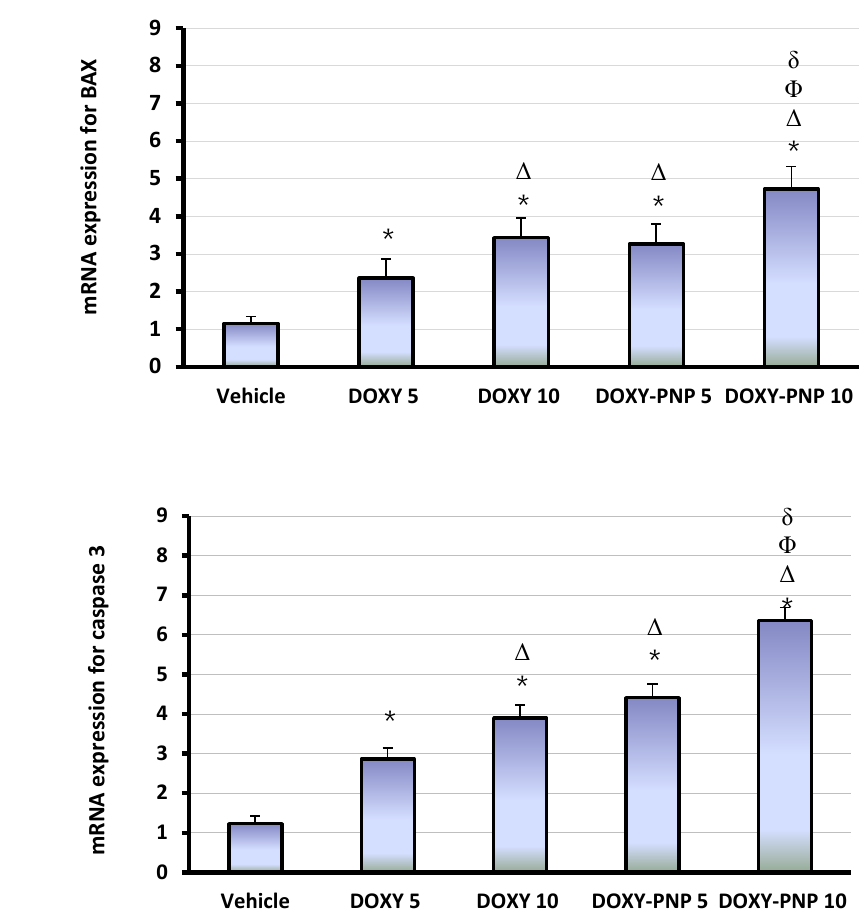
Figure 5. The tumoral mRNA expression for BAX and caspase 3. Column chart demonstrates the mean value of BAX ( A ) and caspase 3 ( B ) expression for each mouse ± SD. Data were analyzed using multivariate ANOVA followed by Bonferroni’s post-hoc test at probability value < 0.05. * Versus vehicle and ∆ versus DOXY 5 mg / kg, Φ versus DOXY 10 mg / kg, δ versus DOXY-PNP 5 mg / kg, n = 6.